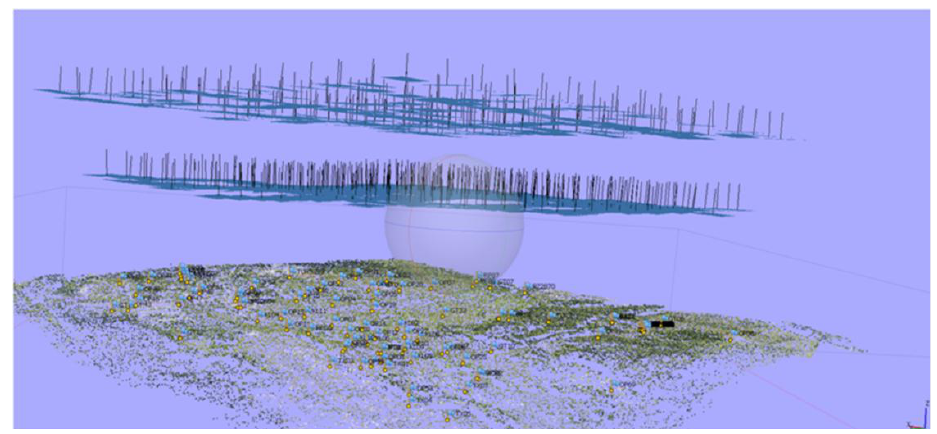
Figure 6. The layout of the aerial photo